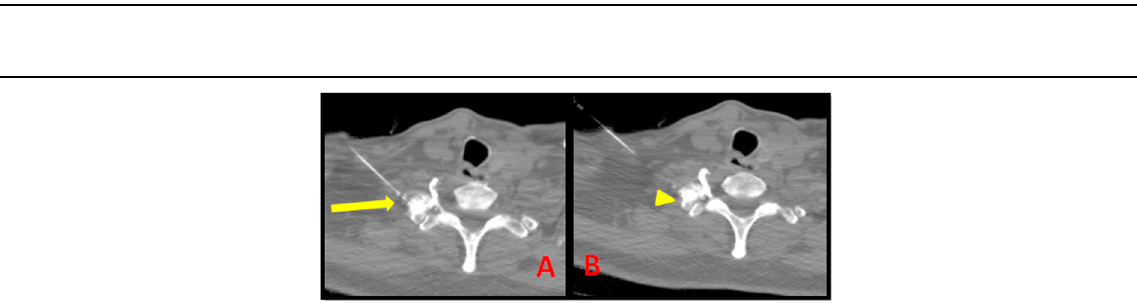
Fig. 11 Antero-lateral approach in stellate ganglion block. Axial CT section ( a ) of the pre-procedure showing the needle tip in the stellate ganglion and post-procedure ( b ) free flow of contrast (arrowhead) in the stellate